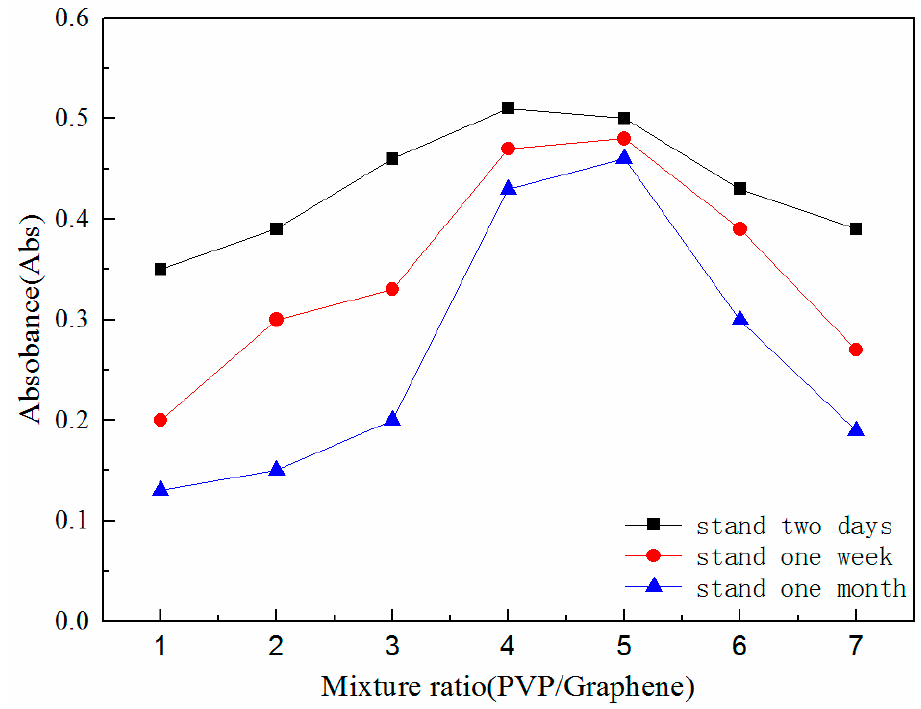
Figure 2. Absorbance of graphene/water nanofluid.